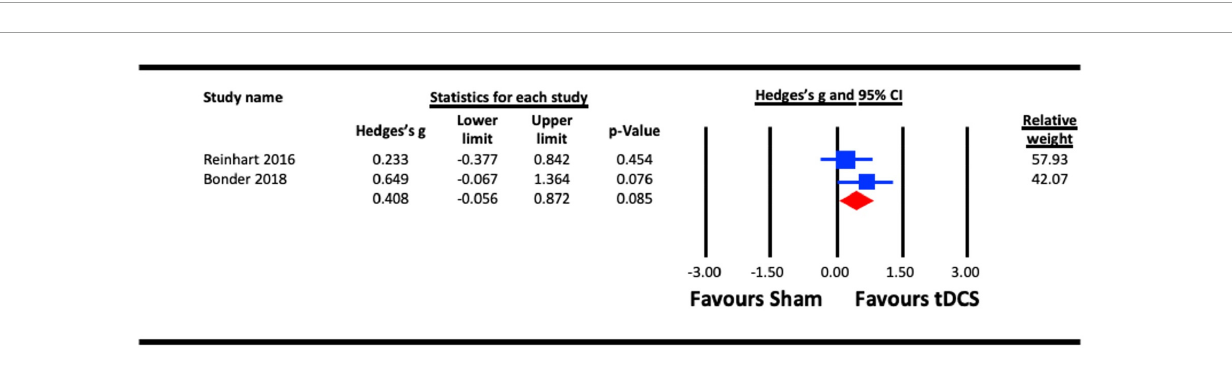
Reinhart et al., 2016; Bonder et al., 2018) were pooled. The result ( Figure 11 ) indicated a statistically non-significant effect of a-tDCS on reaction time (Hedges’s g = − 0.241, 95% CI: − 1.474 to 0.991, p =